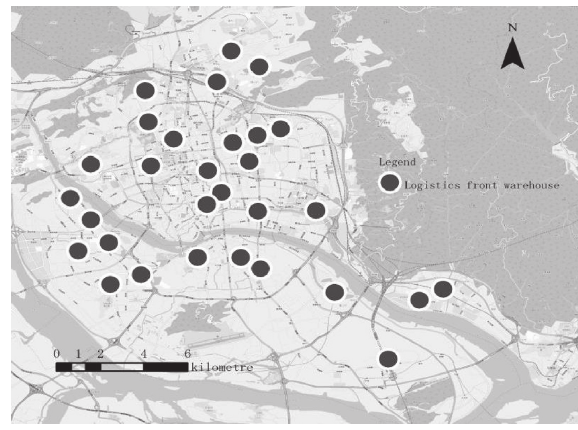
Figure 1: The layout of front